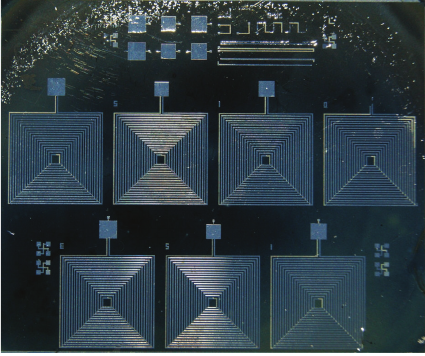
Figure 18: RLC circuits encapsulated in polyimide.